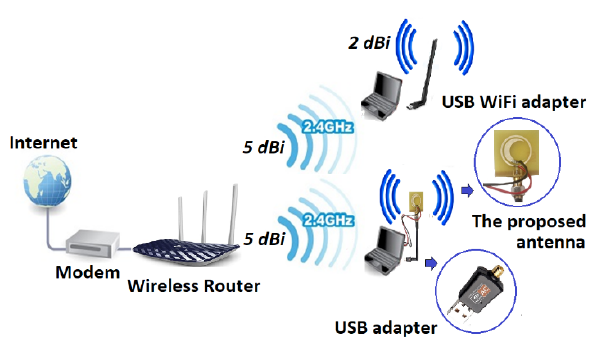
FIGURE 16 . Test set up of the proposed